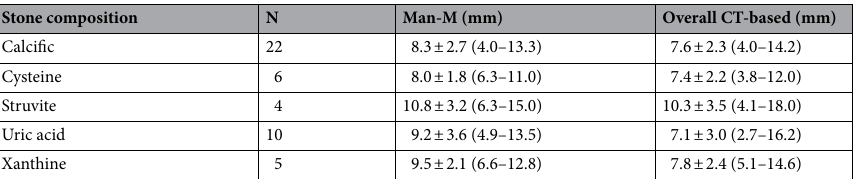
Table 1. Manual measurements and CT-based measurements of the longest diameter regarding different kidney stone composition indicated as mean ± standard deviation (range). N number, Man-M manual measurements. These kidney stones have previously been included in another study (10).